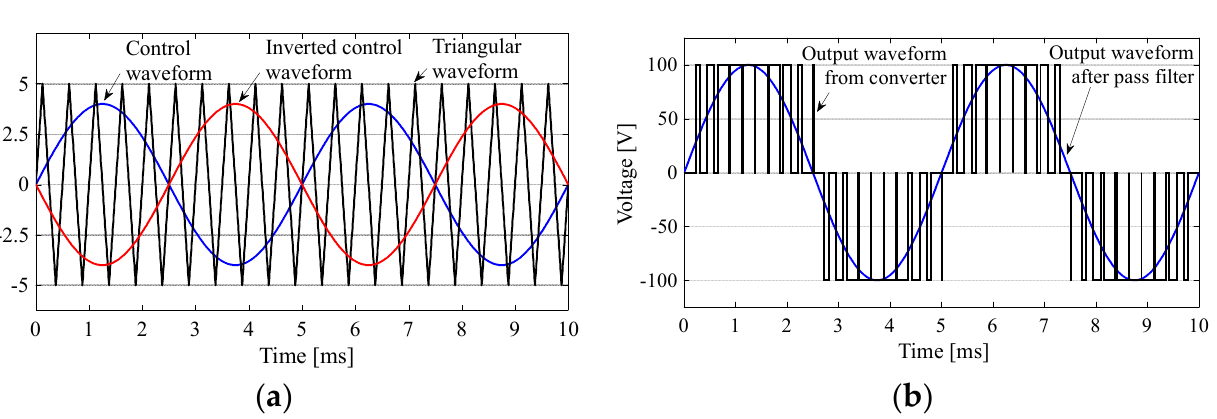
The reference voltage signal, the controlled signal, and the output voltage waveform for the unipolar PWM approach are shown in Figure 7.